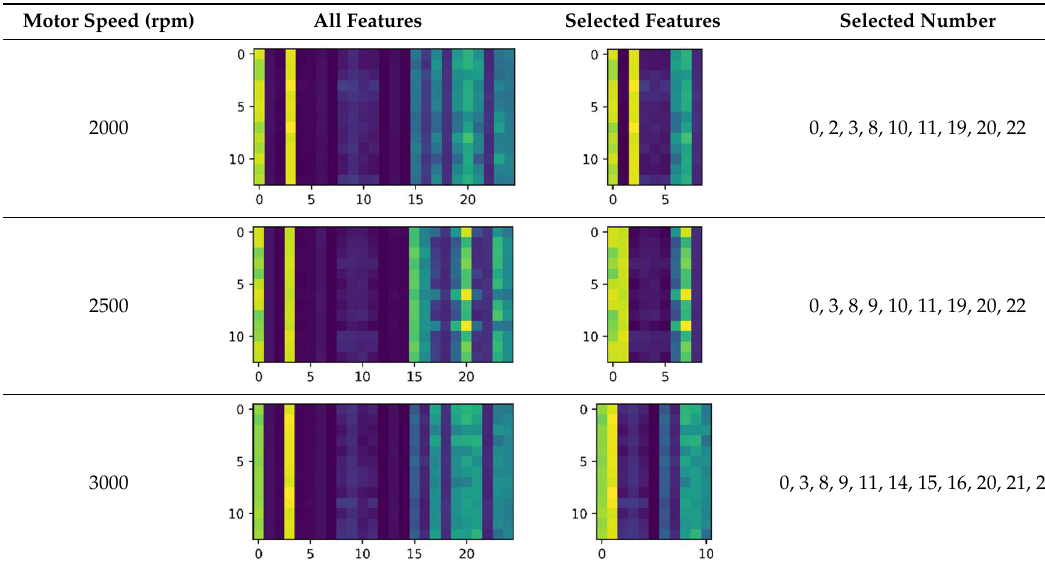
Table 6. Dataset features selected by the proposed method. (The pictures are the visualization results for the corresponding speed samples. The horizontal axis in the figure represents the number of features, and the vertical axis represents the first 13 samples. For the sake of beauty, the first 13 samples are chosen).